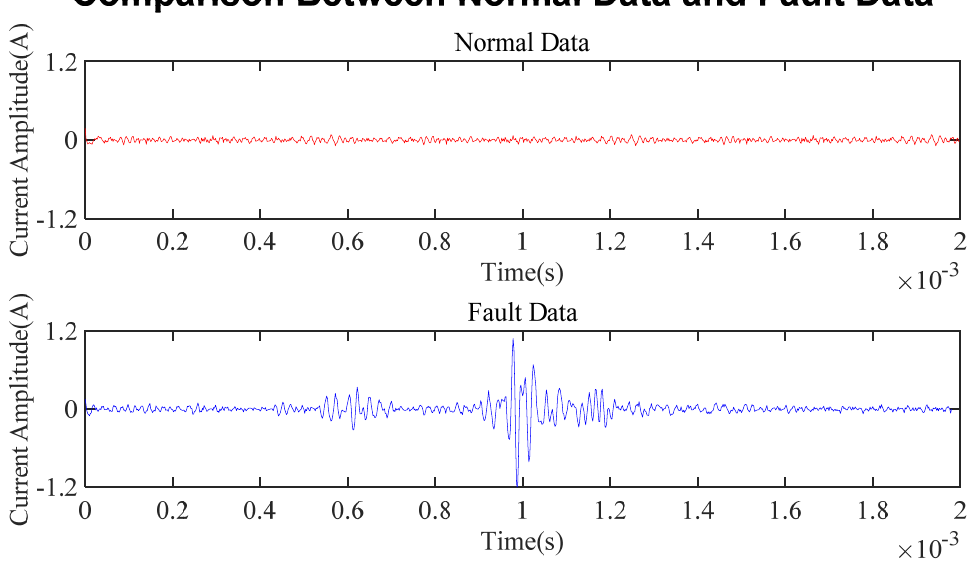
Figure 8. The comparison of current waveforms in the time-domain.